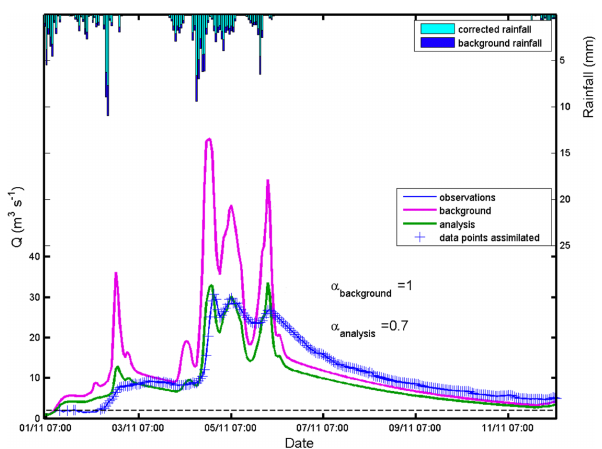
Fig. 7. Reanalysis mode, November 2008: β obs =0.25m 6 s − 2 and S =142mm. The horizontal dashed line is the lower assimilation threshold (2m 3 s − 1 ). Observations are in blue, the background sim- ulation in pink and the analysis simulation in green. Assimilated observations are marked with blue crosses. The hyetogram is on the inverted y-axis: initial rainfall is in dark blue and the corrected rain- fall is in light blue with each bar the width of a 1h time step. This colour scheme is conserved throughout the